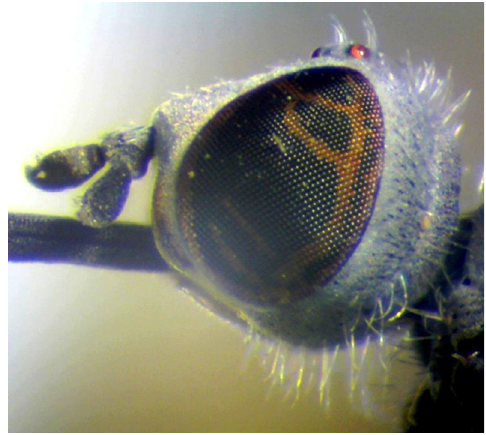
Fig. 24. Protypusia dimonica (Zaitzev, 1996) gen. et comb. nov.,